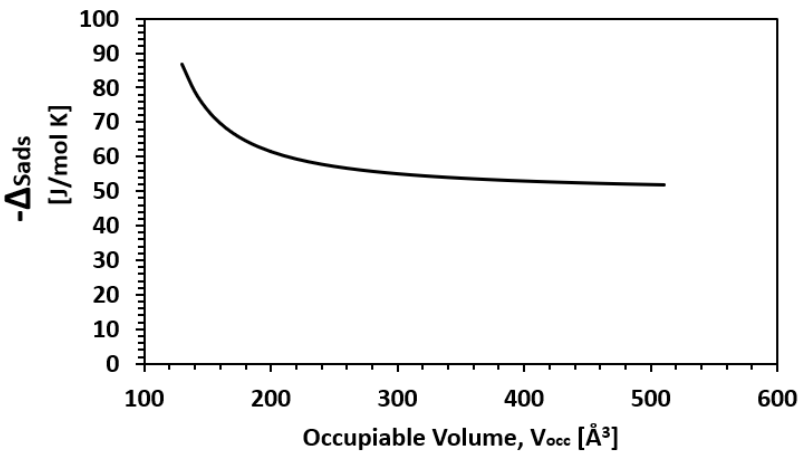
material for various occupiable volumes.